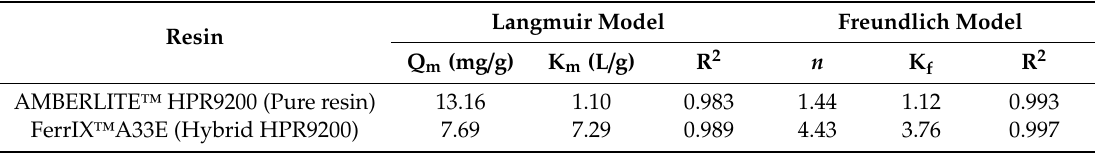
Table 3. Parameters of isotherm models in phosphate adsorption by resins. Q m and K m represent the maximum adsorption (mg P / g) and a parameter related to the bonding strength (L / mg) in the Langmuir model, respectively. K f and n are a parameter related to the adsorption capacity and a parameter related to the intensity of adsorption in the Freundlich model, respectively.